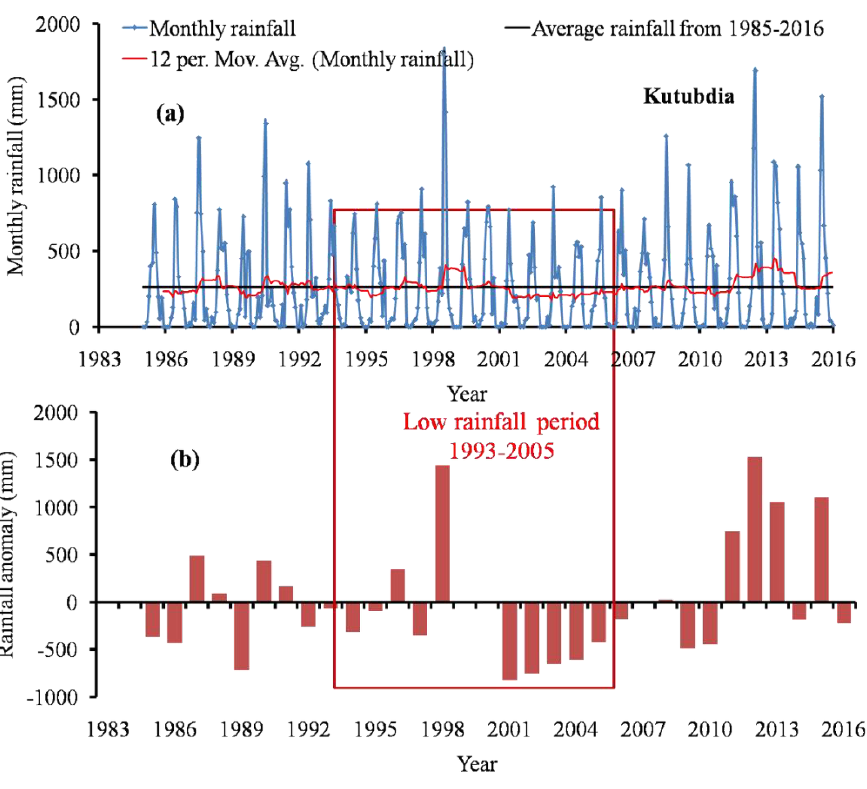
Figure 14. ( a ) Time-series rainfall data from Kutubdia station. ( b ) Rainfall anomaly from 1983–2016. Anomaly represents the fluctuation of the yearly rainfall from the zero mean.